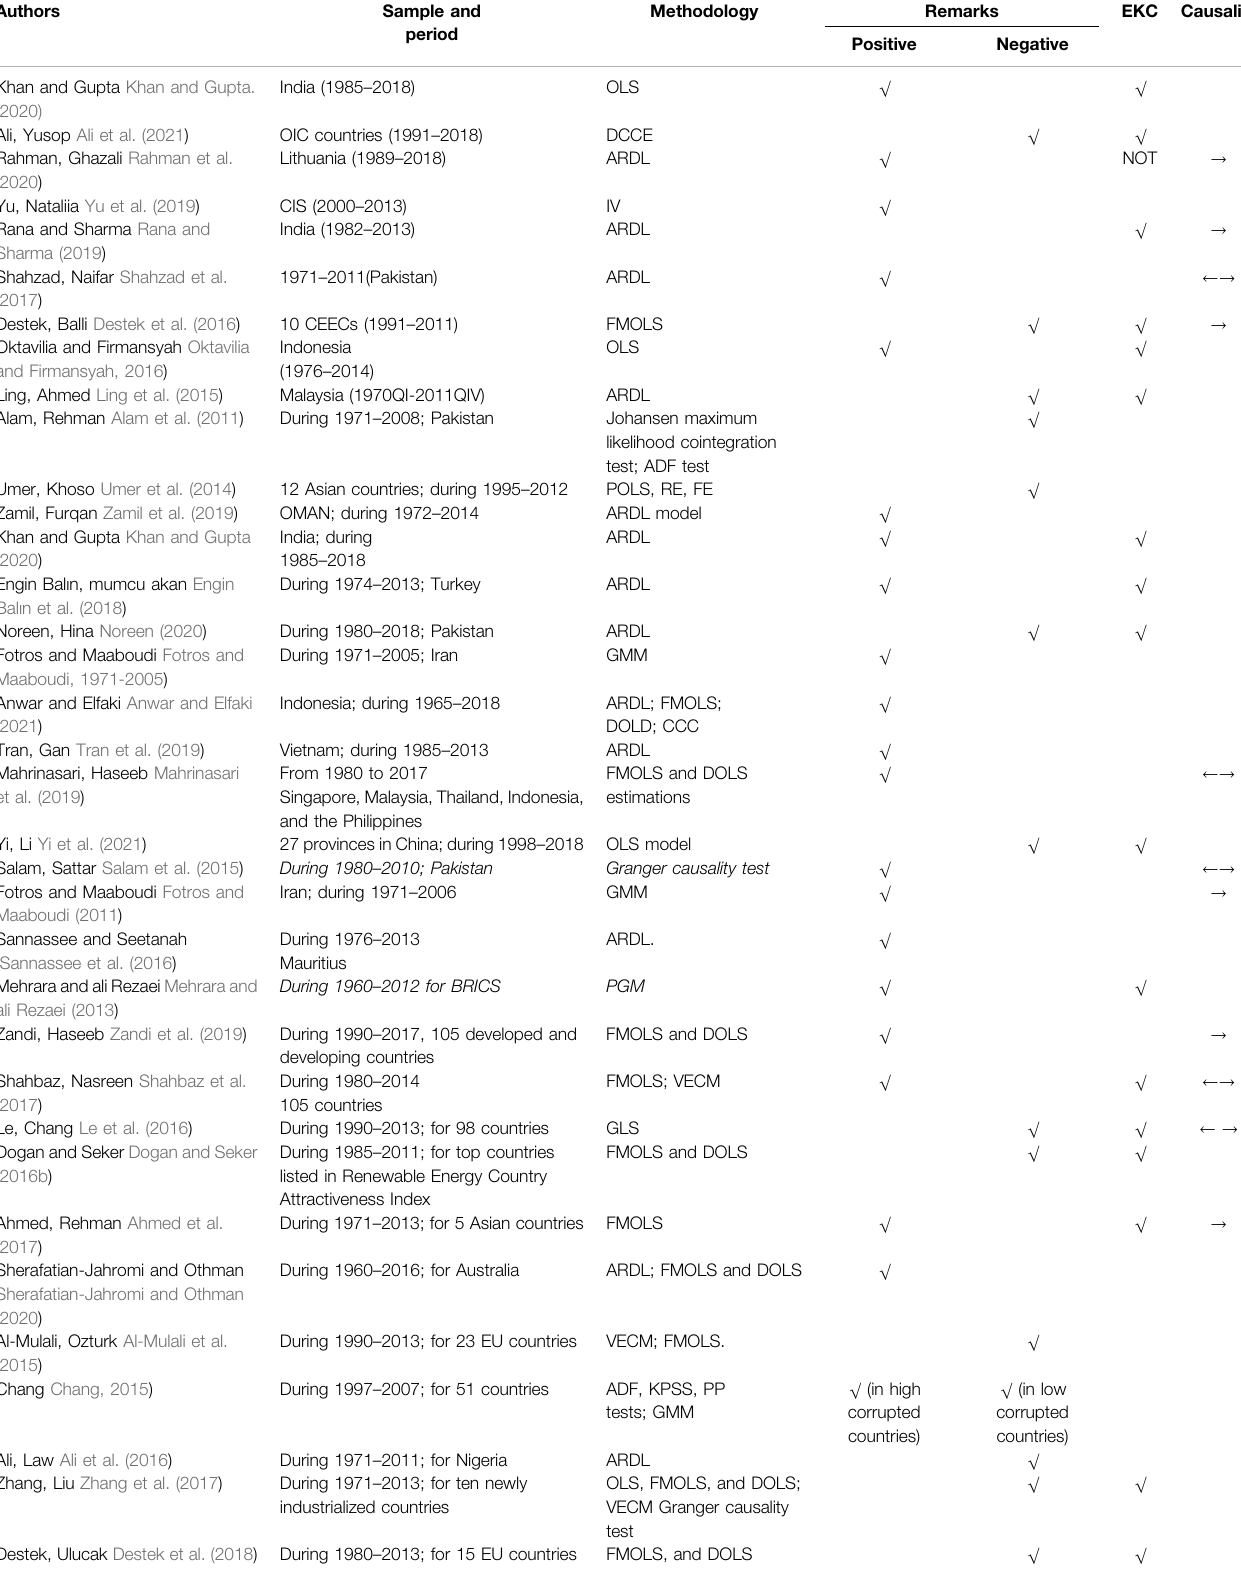
TABLE 2 | Summary of literature survey: nexus between trade and environment